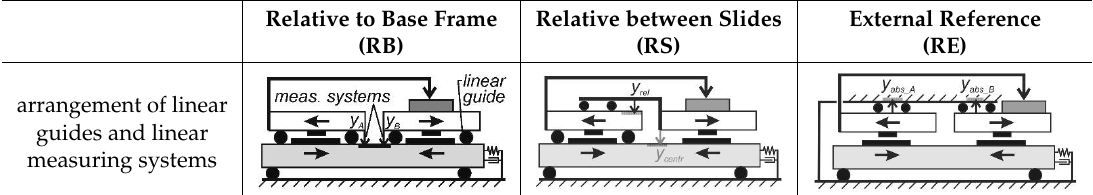
Table 1. Implementation of guiding and measuring systems for redundant axis configurations [11].